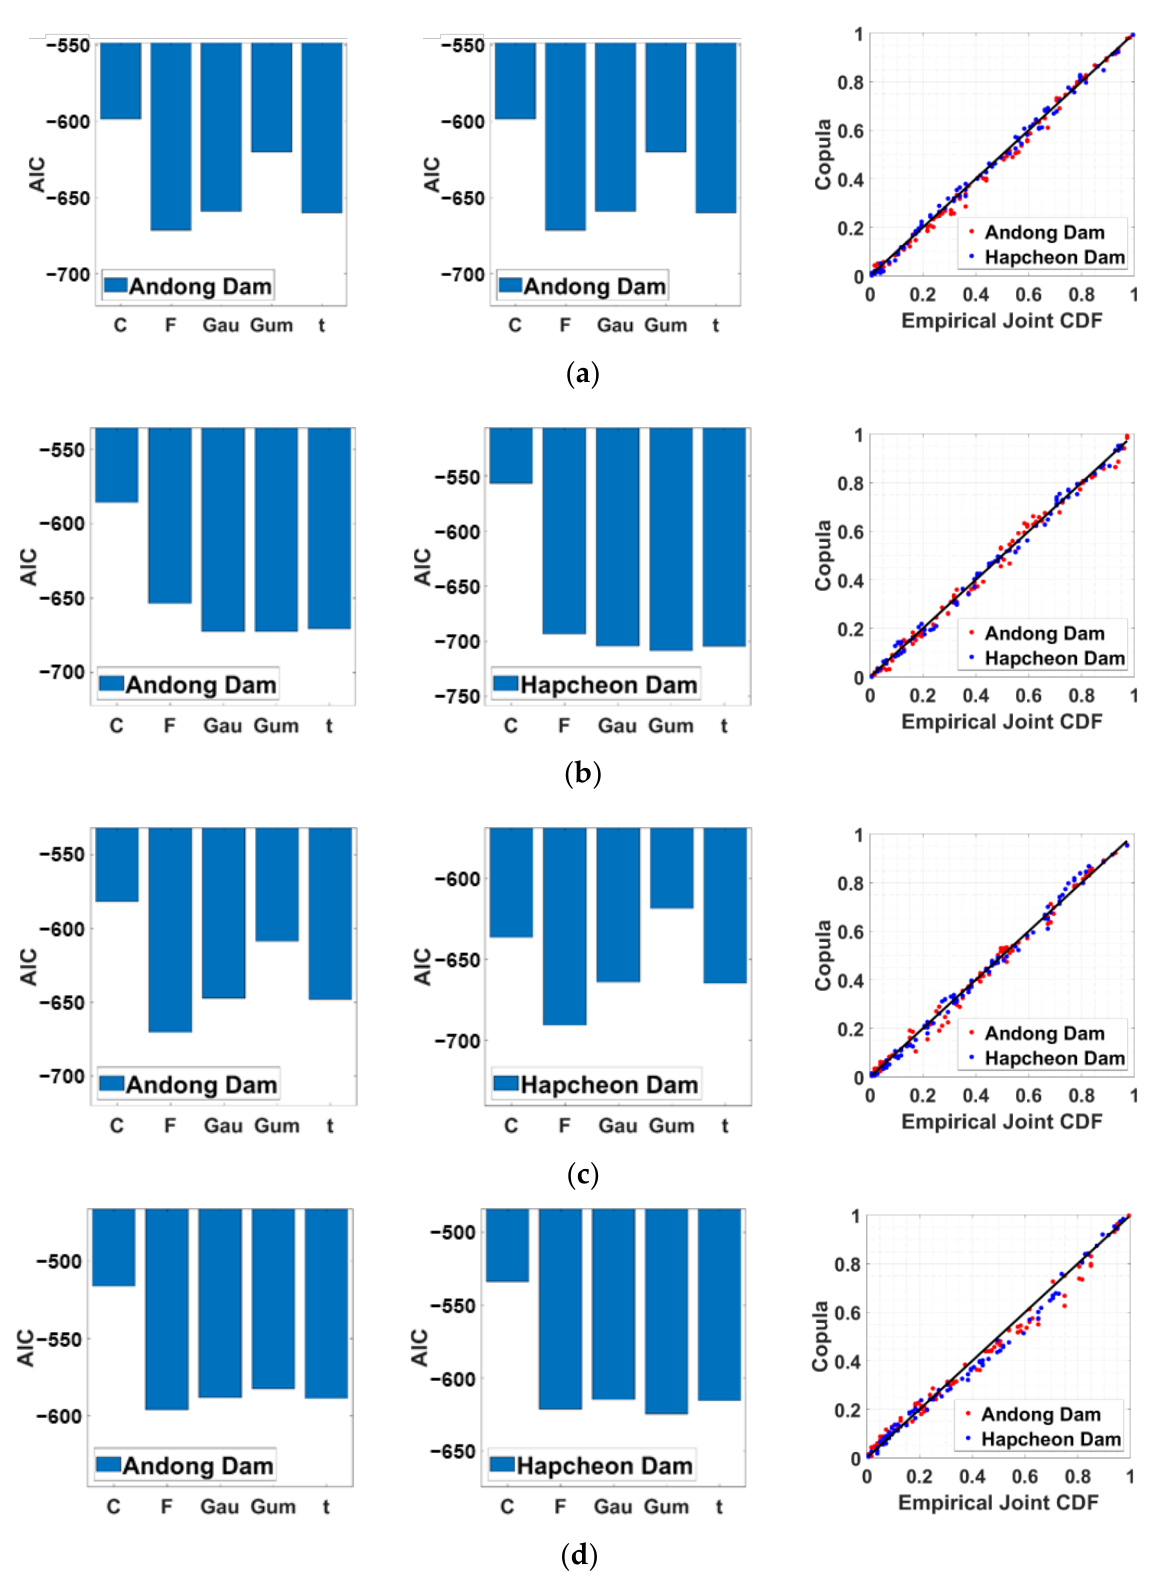
Figure 8. AIC values of five copulas (C, F, Gau, Gum, and t indicate Clayton, Frank, Gumbel, Gaussian, and Student’s t copula, respectively) and Q–Q plot of optimal copula (SPI–SRI): ( a ) spring; ( b ) summer; ( c ) fall; ( d ) winter.